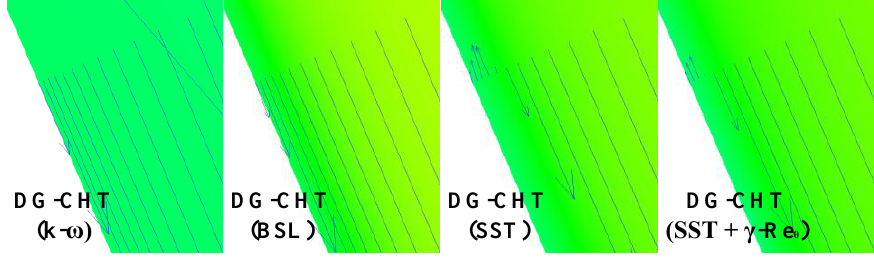
Figure 11. Near-wall velocity vectors just behind the strong shock